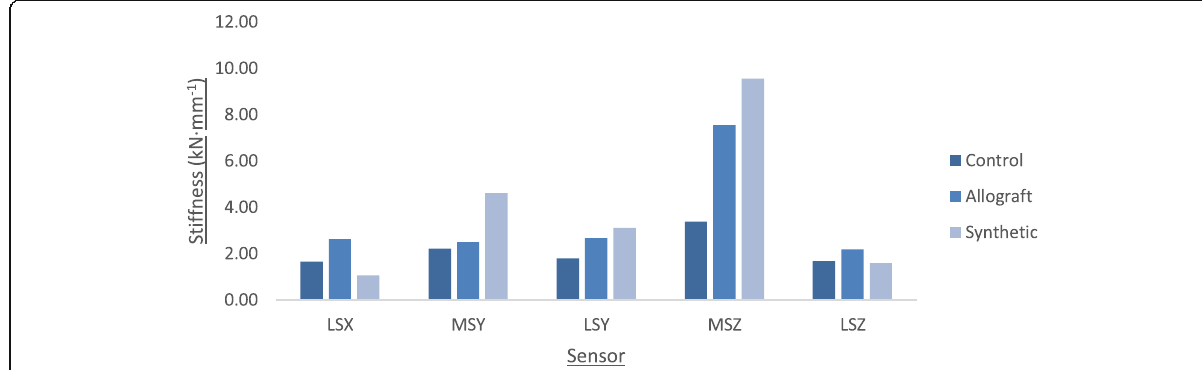
Fig. 6 Graph showing mean stiffness at each sensor position for all groups at time of failure. Allograft Group ( n = 4), Synthetic Group ( n = 4), Control Group ( n =